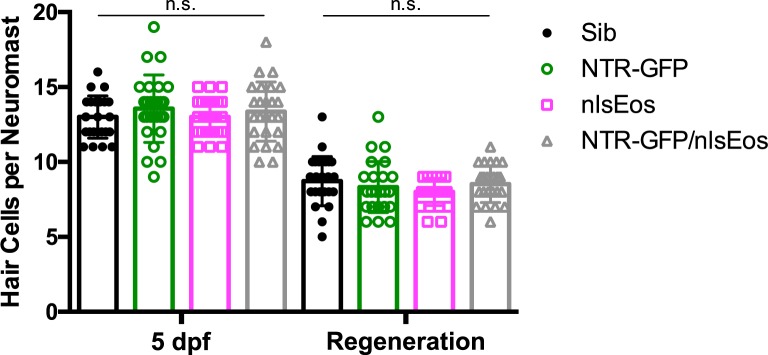
Hair cell development and regeneration is unaffected in fish expressing both sost:NTR-GFP and sost:nlsEos.Total number of FM 1-43FX-labeled hair cells per neuromast at 5 dpf or following hair cell regeneration (72 hpt) in sost:NTR-GFP fish (NTR-GFP), sost:nlsEos fish (nlsEos), sost:NTR-GFP; sost:nlsEos fish (NTR-GFP/nlsEos), and non-transgenic siblings (Sib). 5 dpf: 13.00 ± 1.41 (Sib) vs. 13.56 ± 2.26 (NTR-GFP) vs. 13.00 ± 1.26 (nlsEos) vs. 13.36 ± 1.98 (NTR-GFP/nlsEos), n = 25 neuromasts each (5 fish each); Regeneration: 8.72 ± 1.65 (Sib) vs. 8.32 ± 1.70 (NTR-GFP) vs. 8.00 ± 0.91 (nlsEos) vs. 8.52 ± 1.23 (NTR-GFP/nlsEos), n = 25 neuromasts each (5 fish each); mean ± SD; Kruskal-Wallis test, Dunn’s post-test; 5 dpf: p > 0.9999 (all comparisons); Regeneration: p=0.4448 (Sib vs. nlsEos), p>0.9999 (all other comparisons).10.7554/eLife.43736.021Figure 6—figure supplement 2—source data 1.Hair cell development and regeneration is unaffected in fish expressing bothsost:NTR-GFP and sost:nlsEos